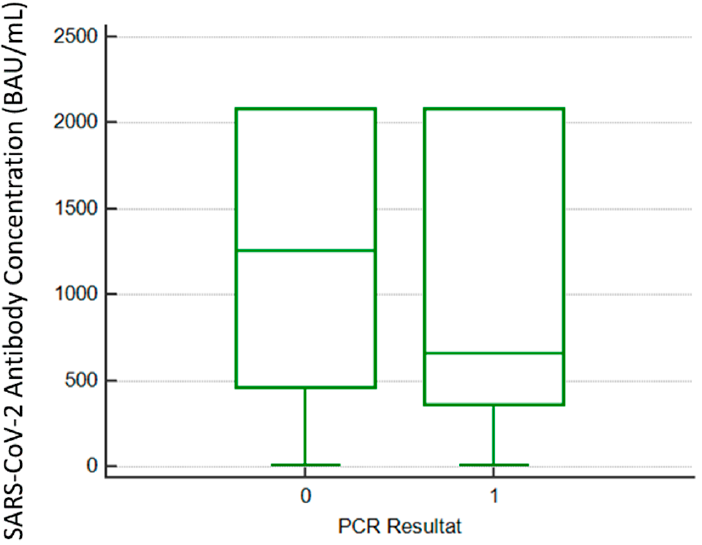
Figure 2. Differences in median BAU/mL SARS-CoV-2 previous antibody levels between 0 = Negative and 1 = Positive HCWs. In both cases the upper range corresponds to the limit of quantification of our assay (2080 BAU/mL).